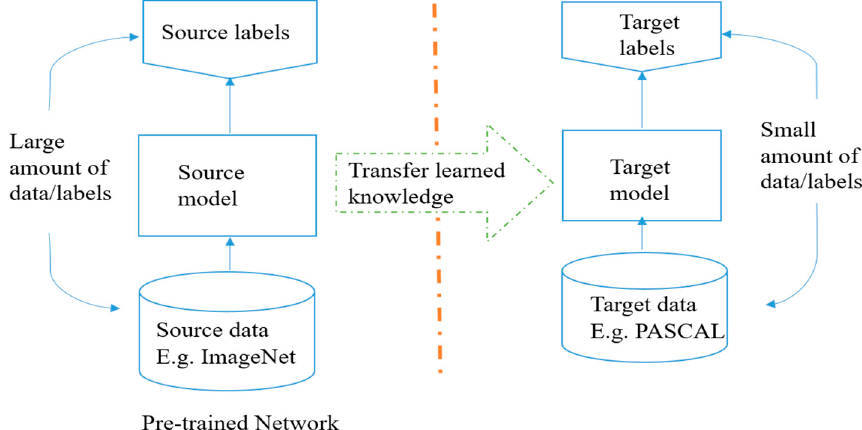
Figure 44. Conceptual diagram for transfer learning: Pretrained on ImageNet and transfer learning is used for retraining on PASCAL dataset.